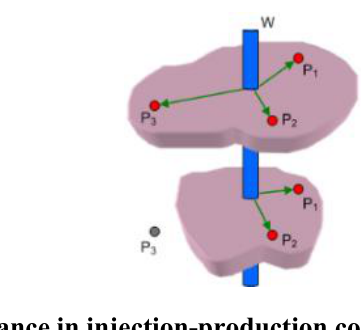
Figure 7—The percolation resistance in injection-production connections in multiple directions in multiple. layers